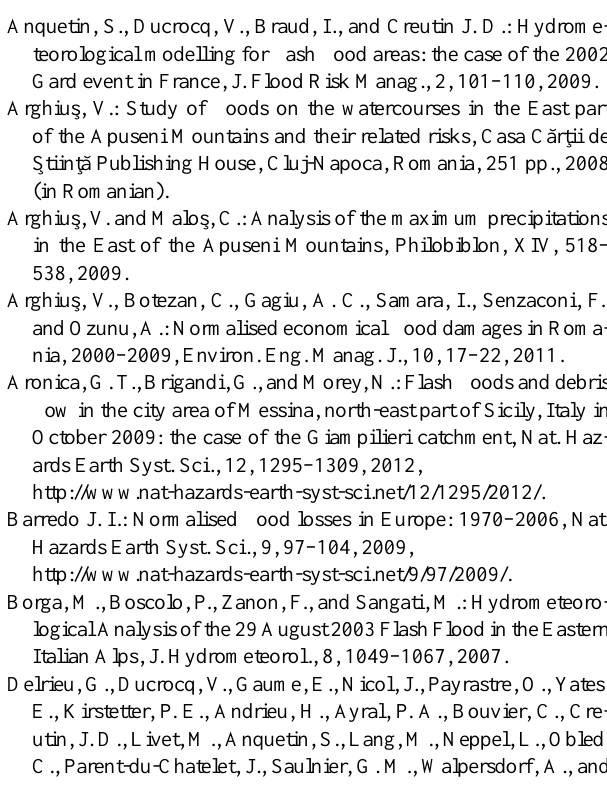
Fig. 6. The flash-flood marks in the affected areas: (a) Lupeni vil- lage – Feernic Basin; (b) Uioara de Jos village – Ciunga Basin.